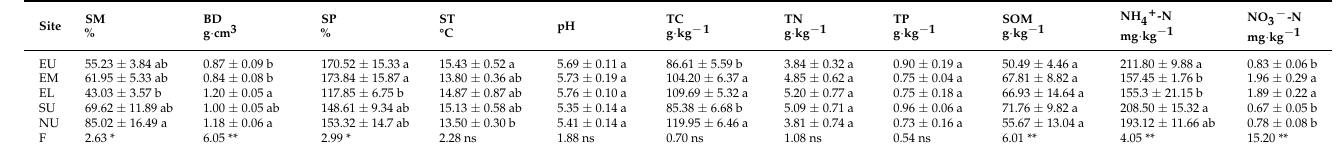
Table 3. Soil physicochemical properties in L. olgensis plantations at different slope aspects and slope